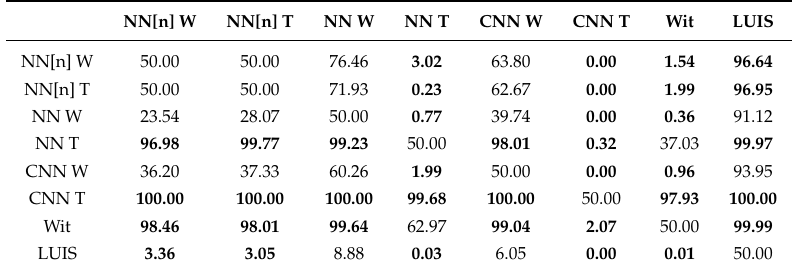
Table A3. Comparison of the models. In row A and column B —the probability (in percent) that model A is better than model B . Probabilities greater than 0.95 (or smaller than 0.05) are shown in